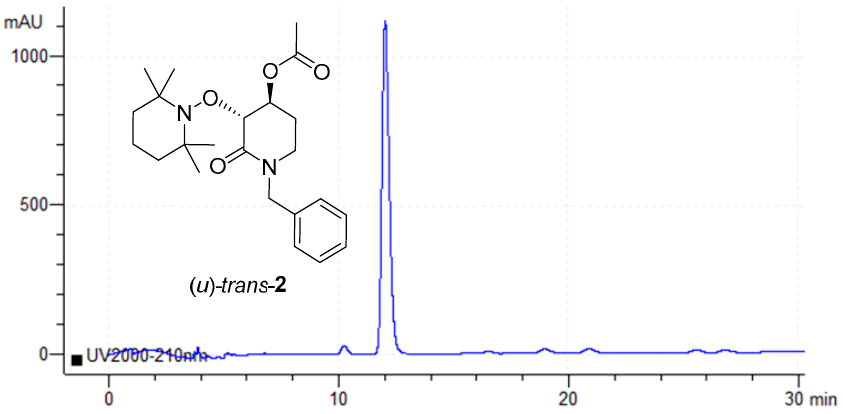
Figure 6. Chiral-HPLC acetylated compound ( u )- trans - 2 after 3 enzymatic resolutions.